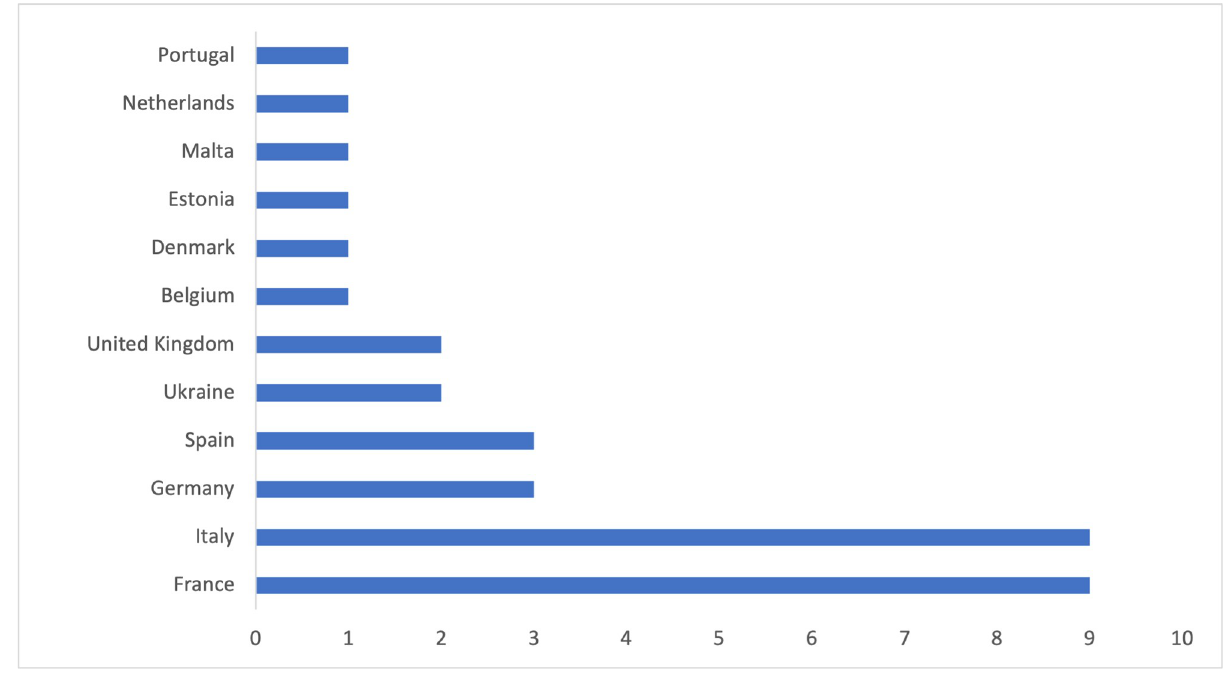
Fig 4. Geographical distribution of the experts.